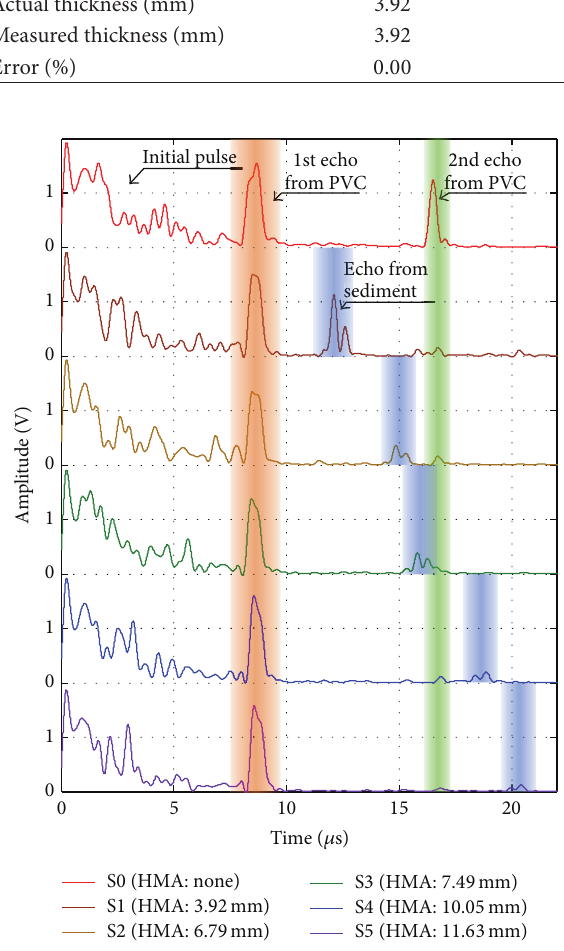
Figure 9: Absolute signal of the reflected ultrasonic